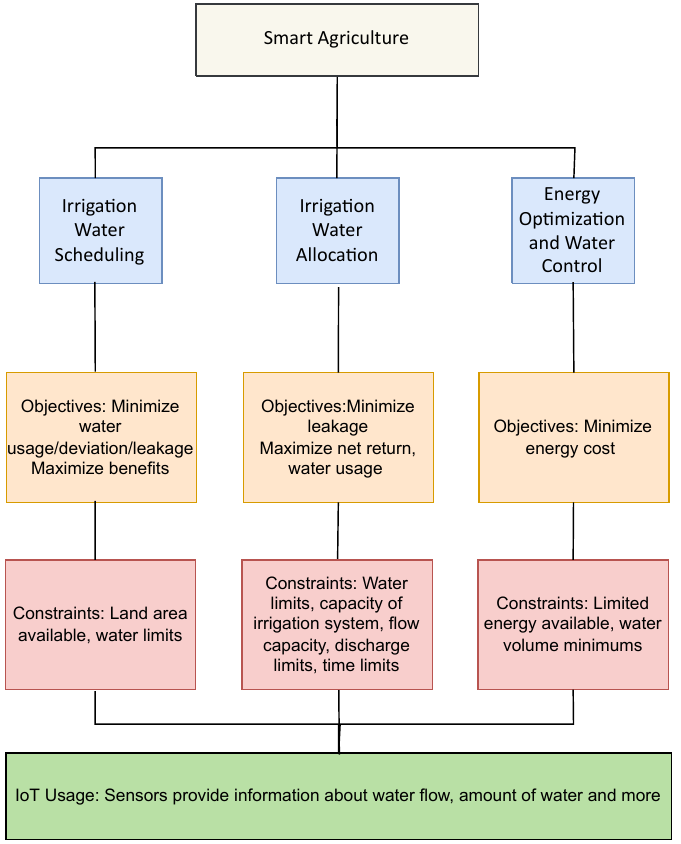
Figure 1. Optimization applications in Smart